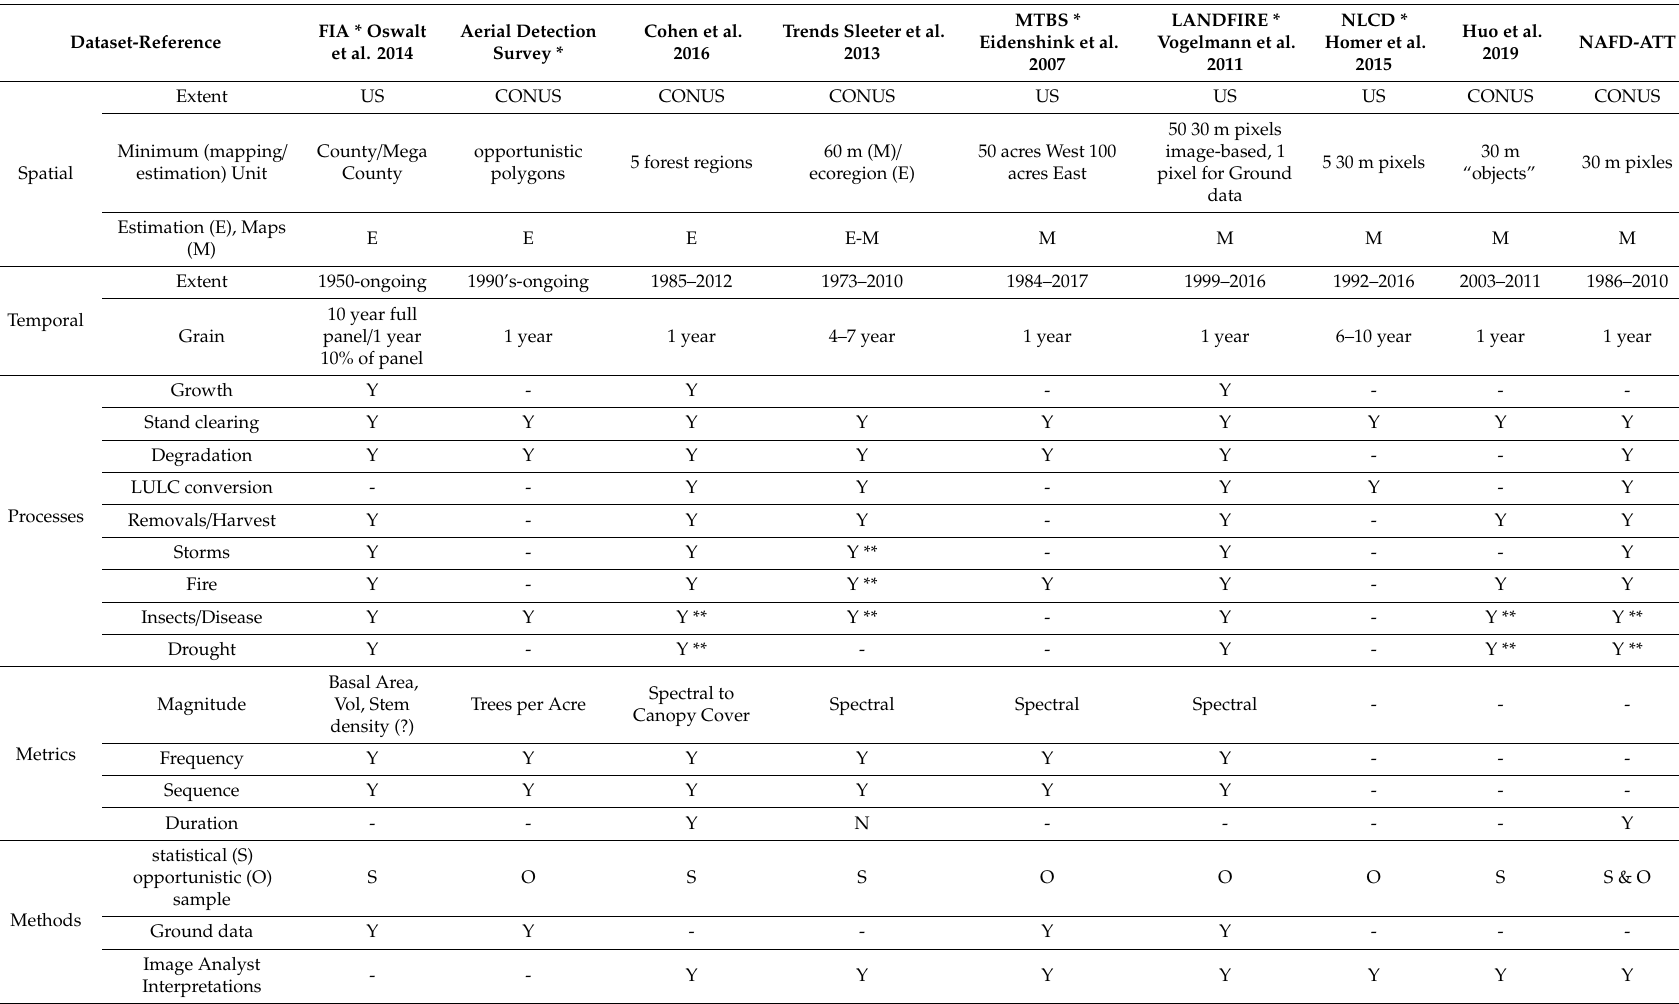
Table 1. Publicly available the conterminous United States (CONUS) datasets attributing forest change processes. * denotes operational projects that are expected to maintain data legacy. ** denotes more than one process that was aggregated into a single type class for attribution. Y is short for “Yes”; N is short for